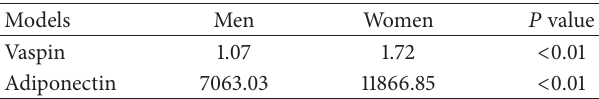
Table 7: Comparisons of serum vaspin and adiponectin levels divided by